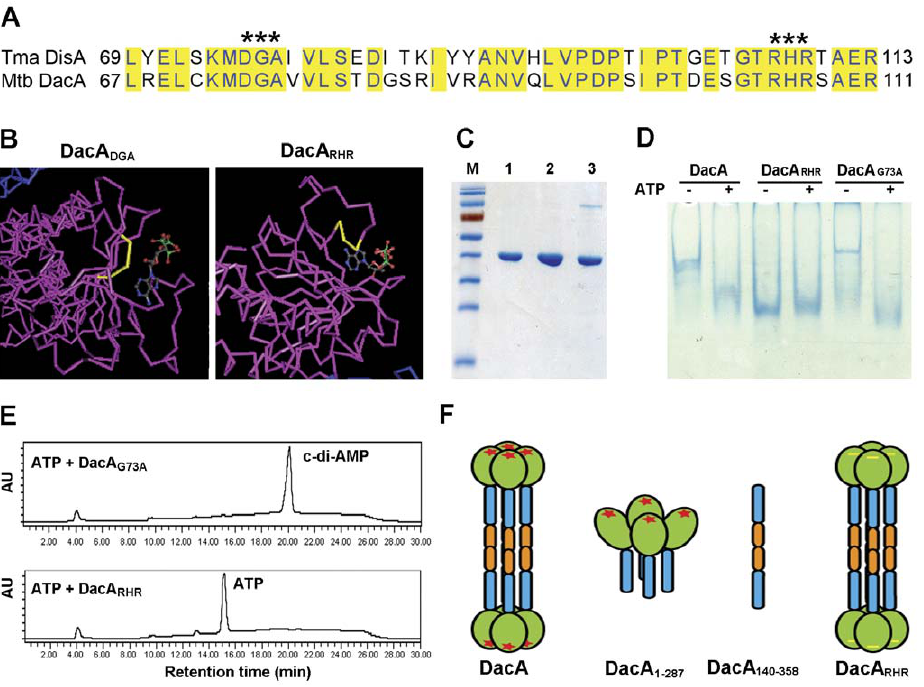
Figure 7. Function of the DGA and RHR motifs in DacA. (A) Partial sequence alignment of M. tuberculosis DacA and T maritima DisA showing the conserved DGA and RHR motifs. Identical residues between the two proteins are highlighted in yellow blocks. (B) Potential contact of DGA and RHR motifs with ATP generated from T. maritima DisA [22] using the Cn3D software. The three amino acids highlighted in yellow represent either DGA or RHR, as indicated. (C) SDS-PAGE of purified DacA, DacA RHR and DacA G73A . Lane M, MW marker; lanes 1–3 are purified DacA, DacA RHR and DacA G73A , respectively. (D) ATP binding by DacA RHR and DacA G73A . Proteins either in the presence ( + ) or absence ( 2 ) of ATP were separated by electrophoresis with a native gel and stained with Coomassie Brilliant Blue. (E) Analysis of diadenylate cyclase activity of 10 m M DacA G73A and DacA RHR in the presence of ATP using HPLC. (F) Structural modeling of DacA and its derivative polypeptides. Three domains of DacA from the N-terminus to the C-terminus are colored in green, blue and orange, respectively. A red star represents one molecule of ATP. A yellow line in DacA RHR indicates the mutation of RHR motif.